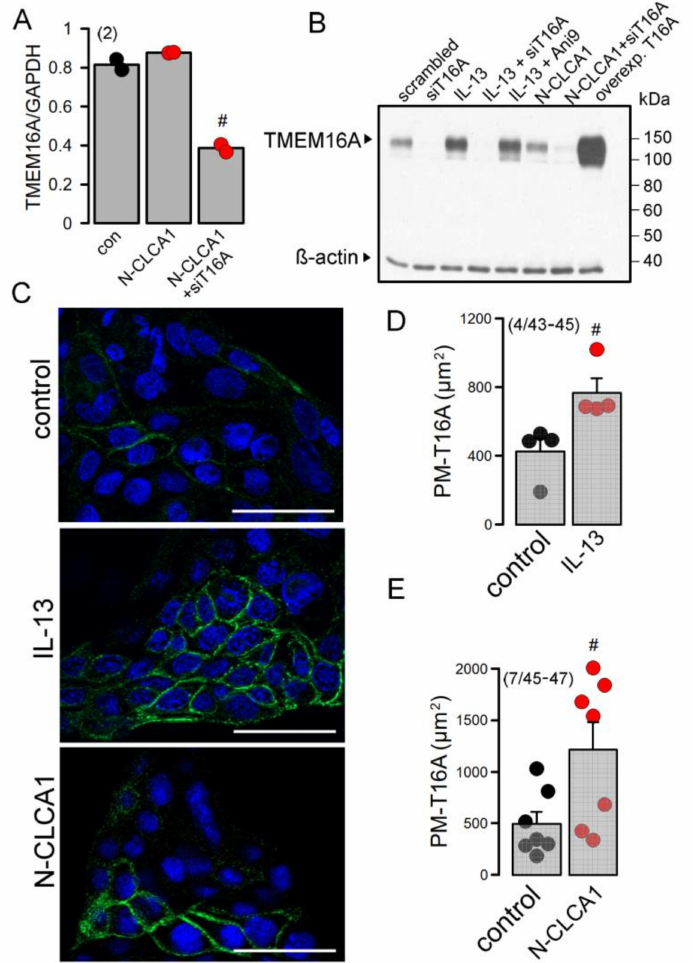
Figure 4. CLCA1 does not enhance expression of TMEM16A but stabilizes TMEM16A in the plasma membrane of Calu3 cells. ( A ) Semiquantitative RT-PCR shows no increase in TMEM16A expression by exposure to N-CLCA1. ( B ) Western blot of TMEM16A indicates increase in expression by IL-13 but not by N-CLCA1. ( C ) Staining of TMEM16A in the plasma membrane indicates low expression in Calu3 cells. Exposure of Calu3 cells to IL-13 (20 ng/mL) increases expression of TMEM16A. N-CLCA1 does not increase the number of Calu3 cells expressing TMEM16A, but rather enhances membrane expression of TMEM16A in some cells. Bars = 50 µ m. ( D ) Quantification of TMEM16A plasma membrane staining in the absence or presence of IL-13. (number of cover slips/number of cells). ( E ) Quantification of TMEM16A plasma membrane staining in the absence or presence of CLCA1. (number of cover slips/number of cells). Mean ± SEM # — significant difference when compared to control or control ( p < 0.05; unpaired t